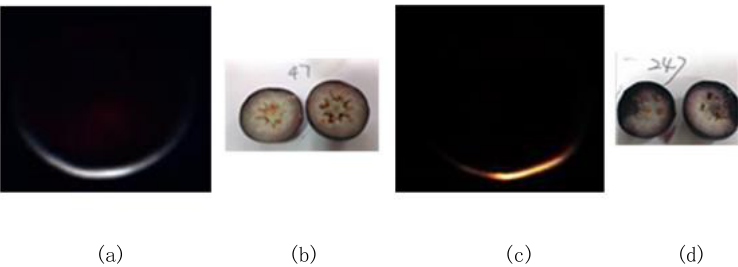
Figure 3. Hyperspectral transmittance images of the sound ( a ) and damaged ( c ) samples and their corresponding ground truth information (( b , d ) for the sound and damaged samples, respectively).